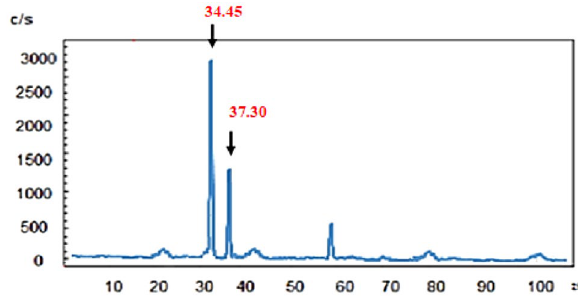
Figure 9. XRD of CuO nanoparticles.